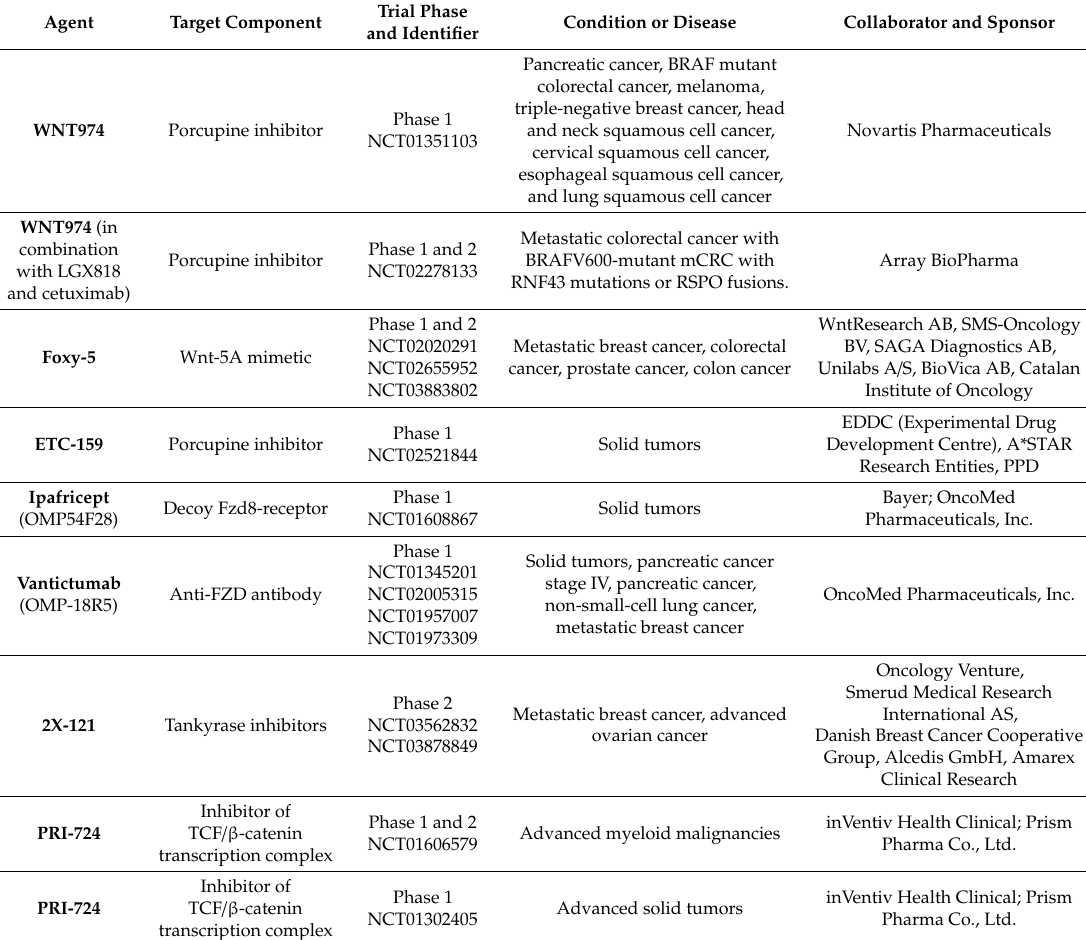
Table 2. Overview of clinical trials for investigated agents targeting Wnt signaling